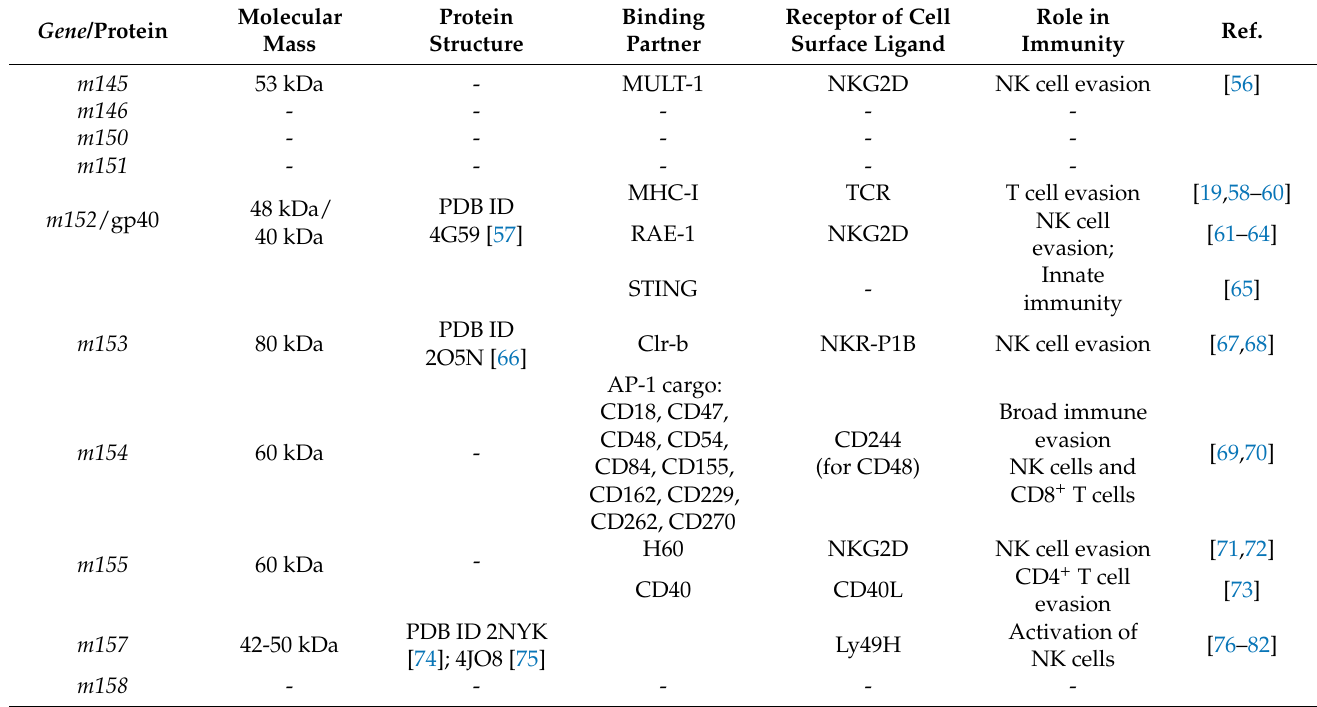
Table 2. Members of the m145 gene family. Experimentally determined molecular masses refer to prevalent glycosylated isoforms; (-) not studied or not applicable.